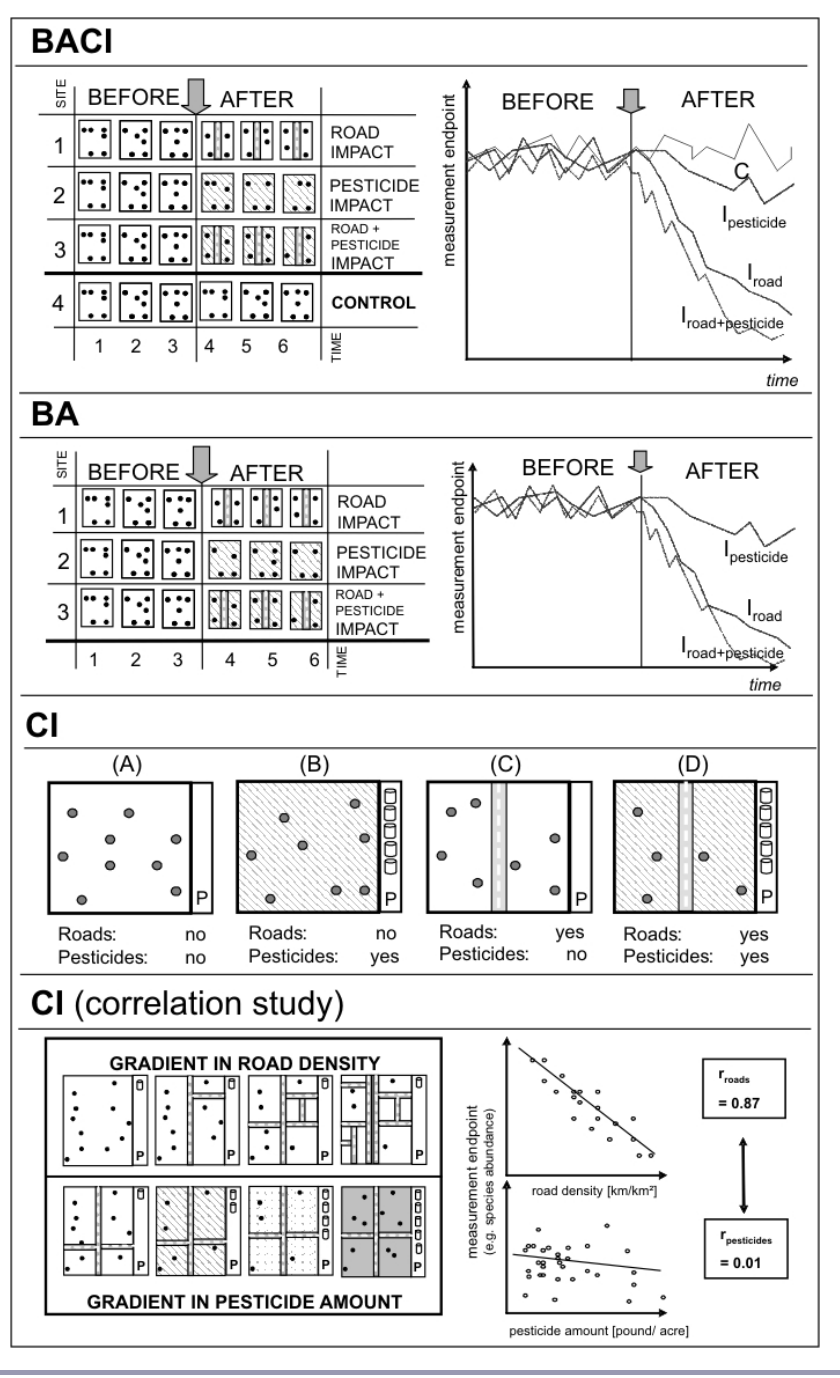
Fig. 4 . Study designs and hypothetical results for Question 2: What is the relative importance of road effects on population persistence? The study types include before-after-control-impact (BACI), before- after (BA), and control-impact (CI) designs. The correlation study is a subtype of the CI